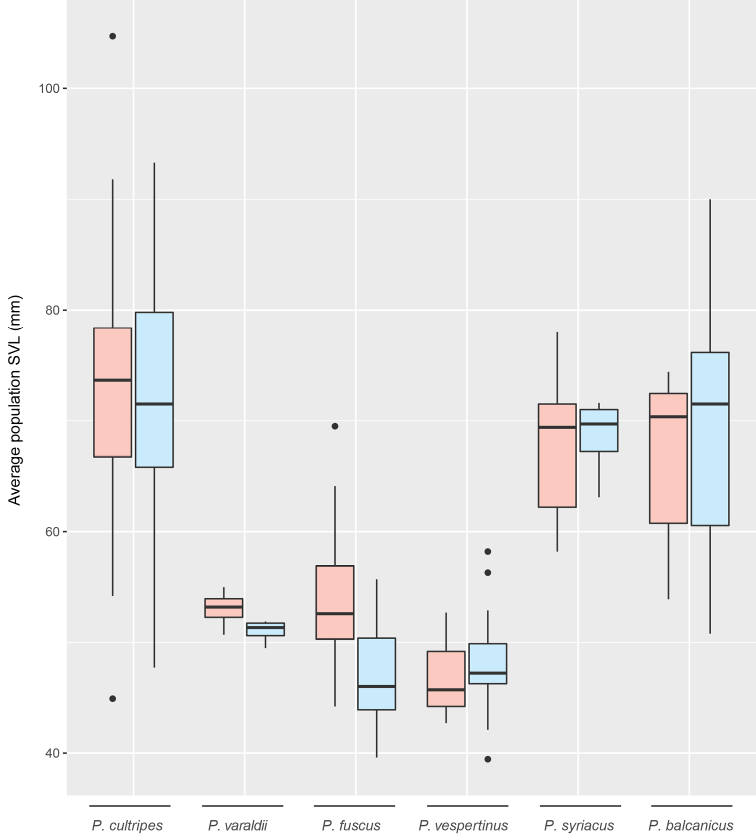
Between-population variation of average size (snout–vent length – SVL) for each Pelobates species, measured separately for females (pink) and males (blue). This compiles average size-data from 82 populations, representing at least 6,004 individuals (Suppl. material 1, Table S1). For P.balcanicus, it only includes populations from the nominal P.b.balcanicus. For P.syriacus, it only includes populations from P.s.boettgeri.